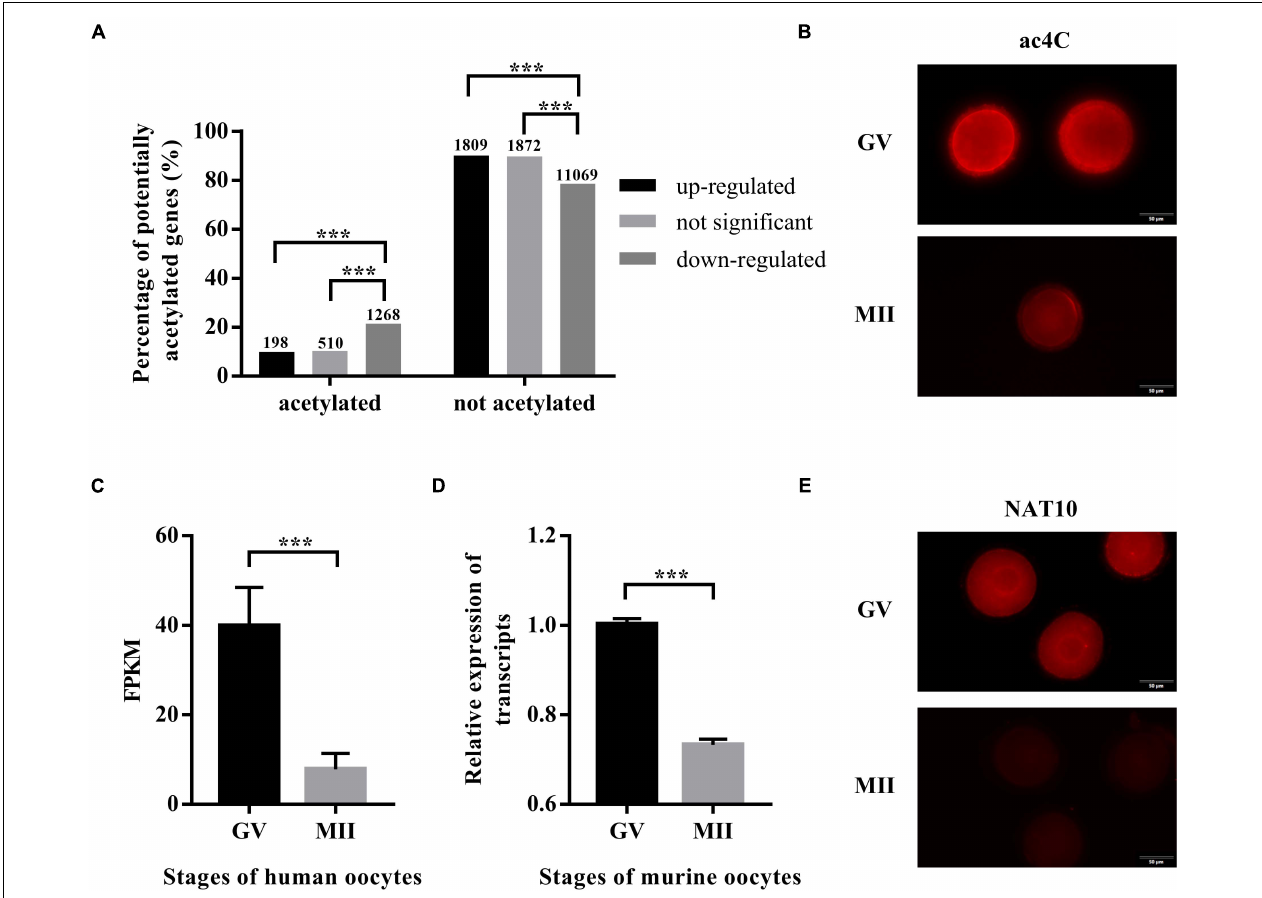
FIGURE 1 | ac4C and NAT10 levels at defined stages of oocyte meiotic progression. (A) Distribution of potential ac4C sites in differentially expressed genes between GV and MII oocytes. The numbers of genes in each category were shown above the bars. These data were obtained from GEO (GSE102113, GSE95477). (B) RNA ac4C modification during mouse oocyte maturation. Exposure time: GV, 300 ms; MII, 1.9 s. Scale bar=50 µ m. (C) Transcriptional levels of NAT10 in human oocytes, logFC = –2.35. Data were obtained from GEO (GSE95477). (D) Transcriptional levels of NAT10 in mouse oocytes, logFC = –2.31. Data were obtained from GEO (GSE5668). (E) NAT10 expression during mouse oocyte maturation. Exposure time: GV, 93 ms; MII, 200 ms. Scale bar=50 µ m. GV, germinal vesicle. MII, metaphase II. FC, fold change. FPKM, fragments per kilobase per million. The immunostaining was repeated in at least three independent experiments. ***Significant difference at p <